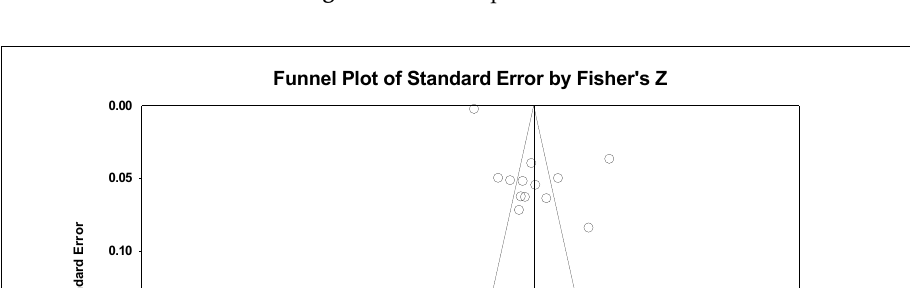
Figure A5. Funnel plot of AT - SEI.